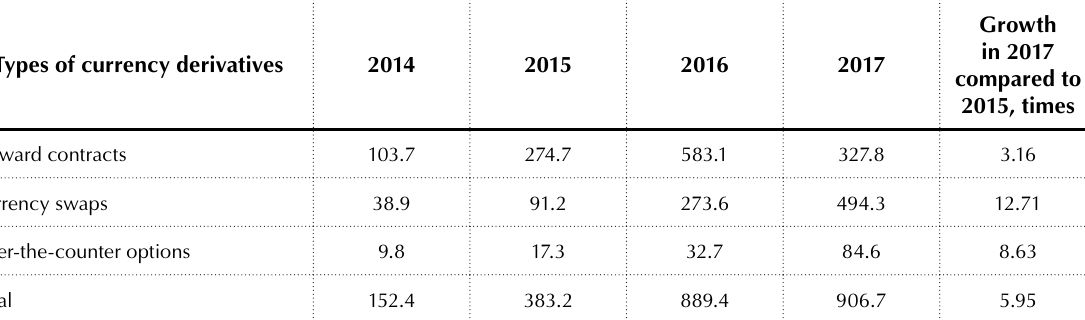
Table 4. Use of currency derivatives by Ukrainian banks to hedge currency risks in the period